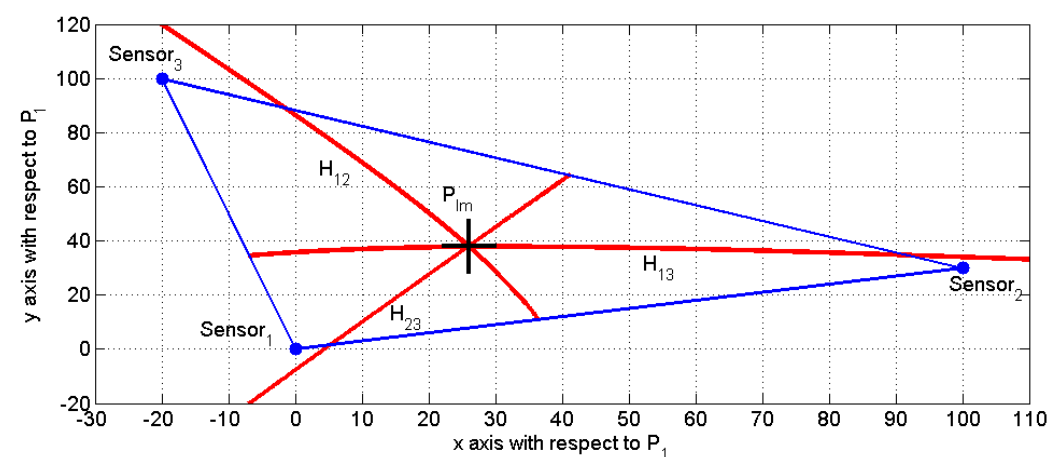
Figure 3. Sensor location, impact point and hyperbola